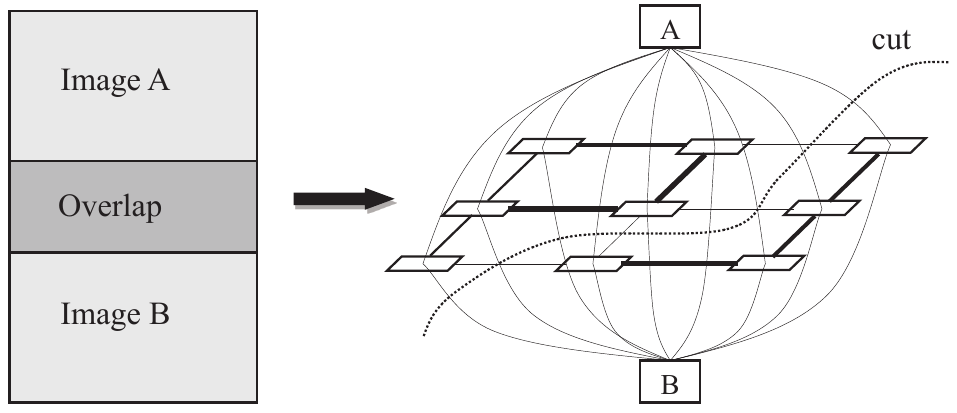
Figure 6. An illustration example of detecting the optimal seamline between two images via graph cuts. The thickness of lines between adjacent pixels represents the value of the energy cost and the “cut” denotes the minimum cut, which means the optimal